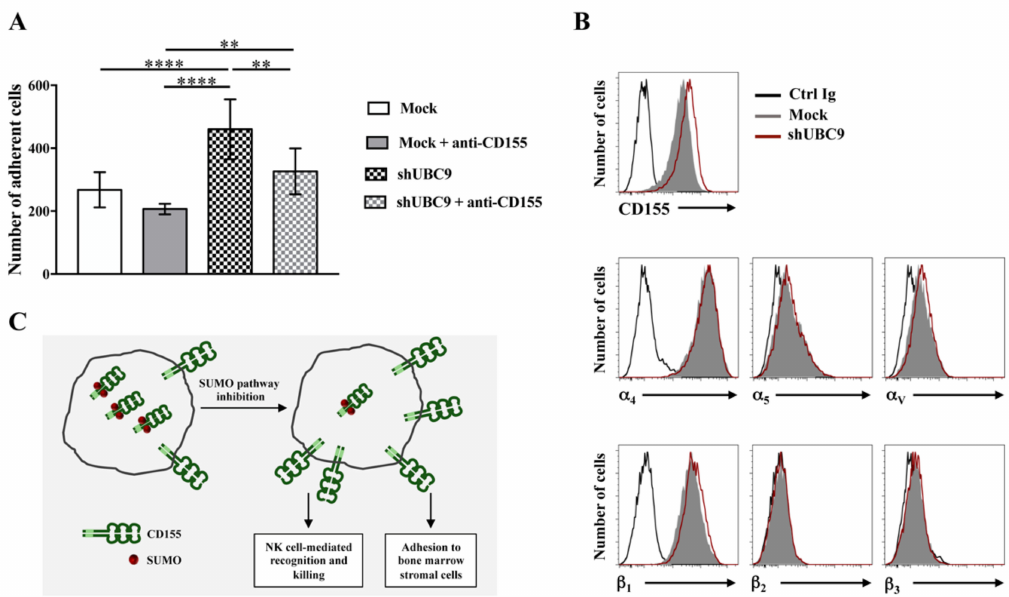
Figure 3. Inhibition of small ubiquitin-like modifier (SUMO) pathway increases MM adhesion to BMSCs. Knock down of the UBC9 SUMO conjugating enzyme in ARK cell line was obtained through shRNA-expressing lentiviral vectors, as previously described [63]. ( A ) UBC9 silenced or infected with the control vector pLKO non-targeting shRNA (Mock) ARK cells were labeled with the red fluorescent dye PKH26 and incubated for 20 min at 4 ◦ C with anti-CD155 monoclonal Ab (clone D171, Thermo Scientific) or with isotype matched control Ab. After washing, cells were left to adhere to a monolayer of HS5 bone marrow-derived stromal cells for 2 h at 37 ◦ C. Cells were washed three times with PBS and fixed. Adherent cells were visualized with IX73 microscope equipped with a 10X objective and quantified with FIJI software. Means ± SD of 10 randomly acquired fields from each experiment of three independent experiments are shown. **** p < 0.0001, ** p < 0.01, Two-way ANOVA. ( B ) UBC9 silenced (empty red histogram) and mock-infected (filled gray histogram) cells were analyzed by FACS for surface expression of CD155 and α / β integrin subunits using the following Abs: anti- α 4 (clone P4G9, Telios Pharmaceuticals), anti- α 5 (clone SAM-I, Immunotech), anti- α v (clone AMF7, Immunotech), anti- β 1 (cloneTS2.16, generous gift from Dr. F. Sanchez-Madrid), anti- β 2 (clone TS1.18, generous gift from Dr. F. Sanchez-Madrid) and anti- β 3 (clone BB10, Chemicon) Abs. Isotype control staining is also shown (Ctrl Ig, empty black histogram). Data from one representative experiment out of two independent experiments is shown. ( C ) Working model illustrating how SUMO modification regulates CD155 expression and functions in MM